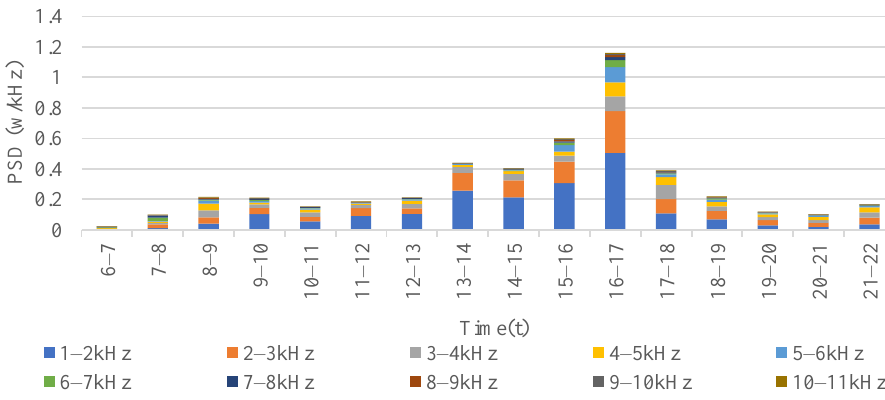
Figure 6. Diurnal variation of acoustic power spectral density in 10 frequency ranges.